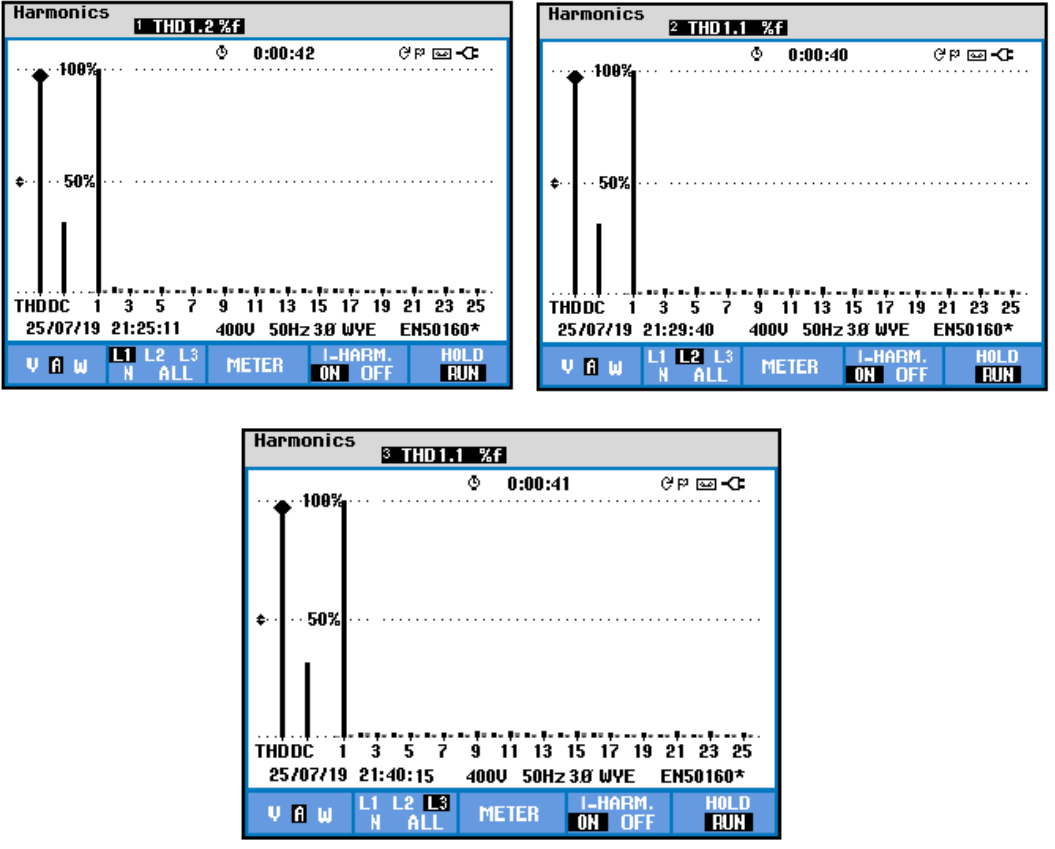
Figure 15. THD level of source current after connecting solar photovoltaic-supported QZSI-unified power quality conditioner.